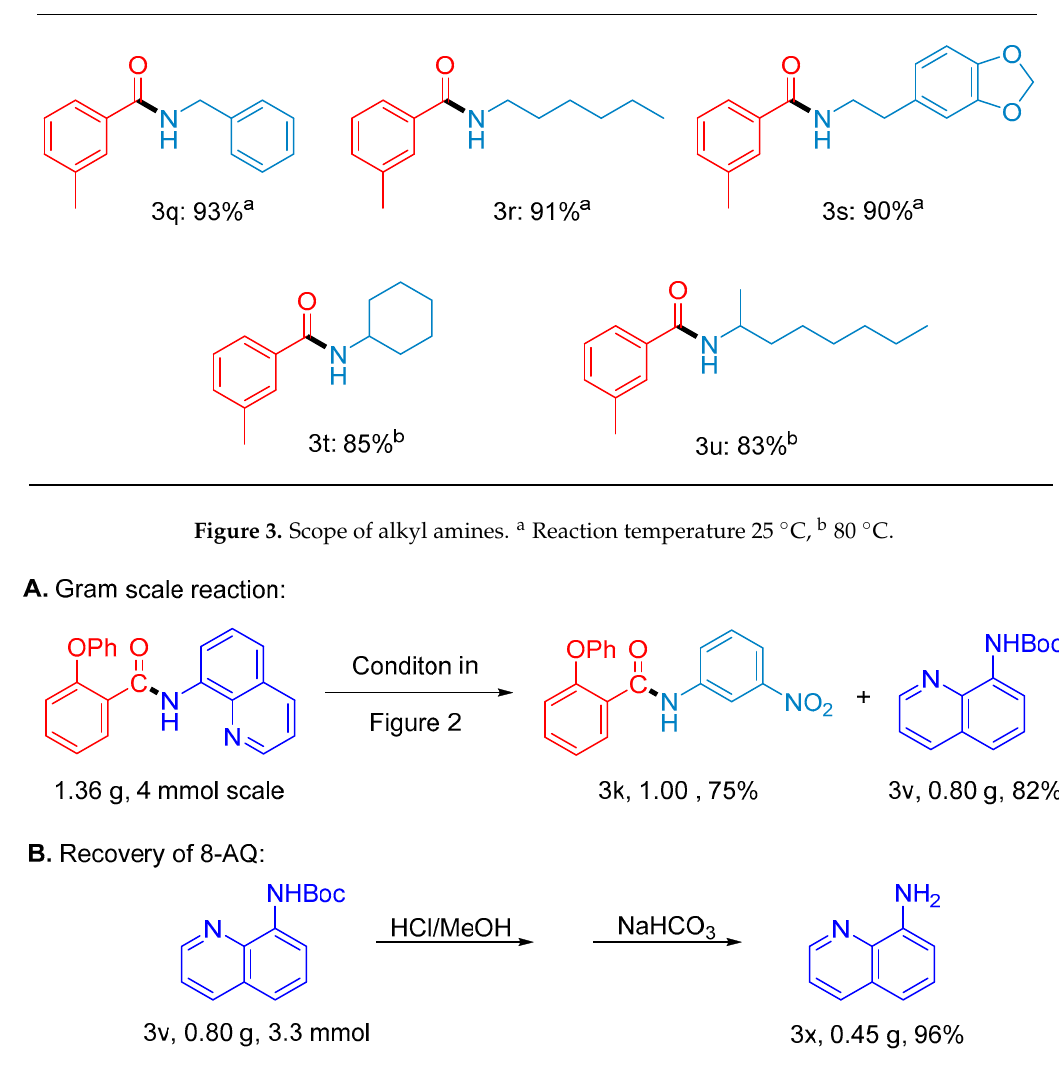
Scheme 2. Gram-scale reaction and recovery of